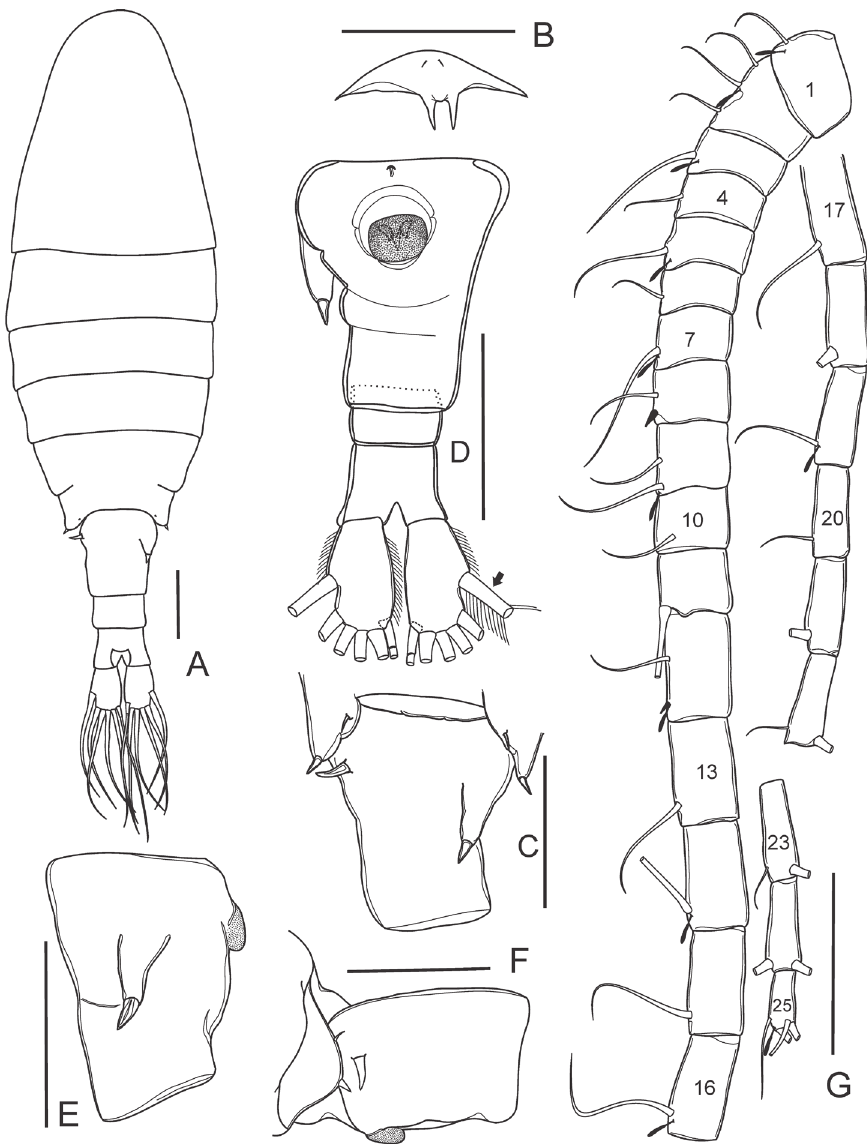
Figure 1. Mongolodiaptomus loeiensis sp. n. Female: A habitus, dorsal view B rostrum, frontal view C lateral wings on pediger 5 and genital somite, dorsal view D urosome, ventral view (black arrow points to smooth region of lateral seta) E genital somite, lateral view F lateral wing on pediger 5 and genital somite, lateral view G antennule. Scale bar 100